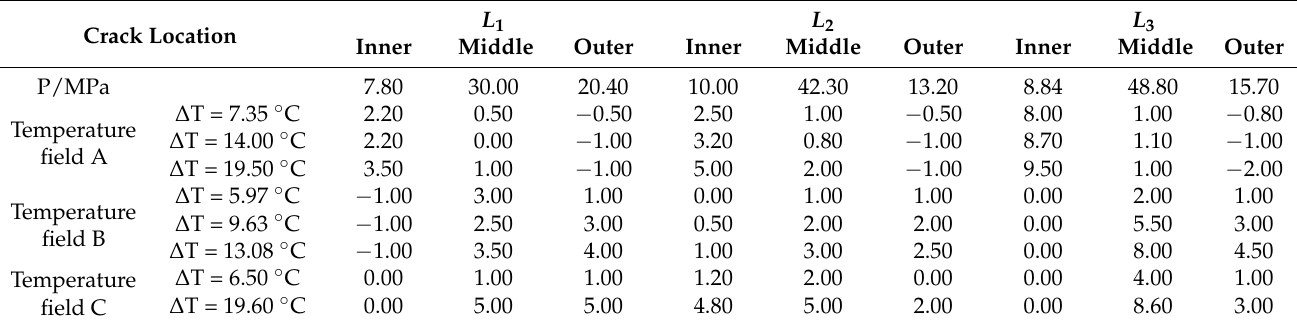
Table 2. Crack width (unit: 0.01